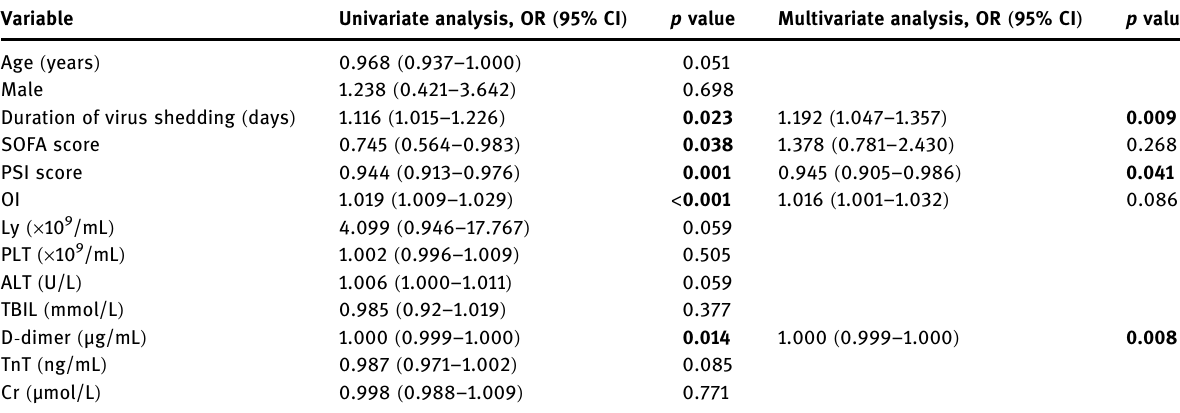
Table 4: Multivariate analysis of independent risk factors for di ff erentiating COVID - 19 from in fl uenza A infection